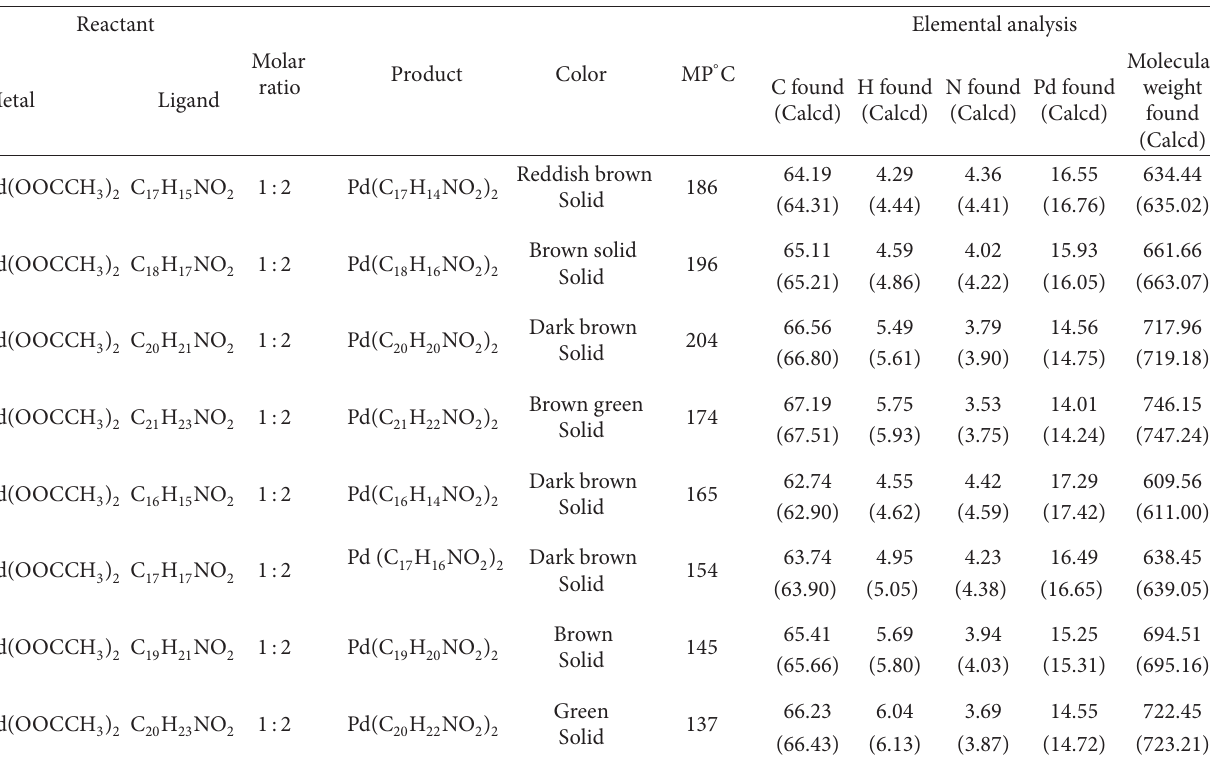
T 2: Analytical and physical data of the Pd(II)